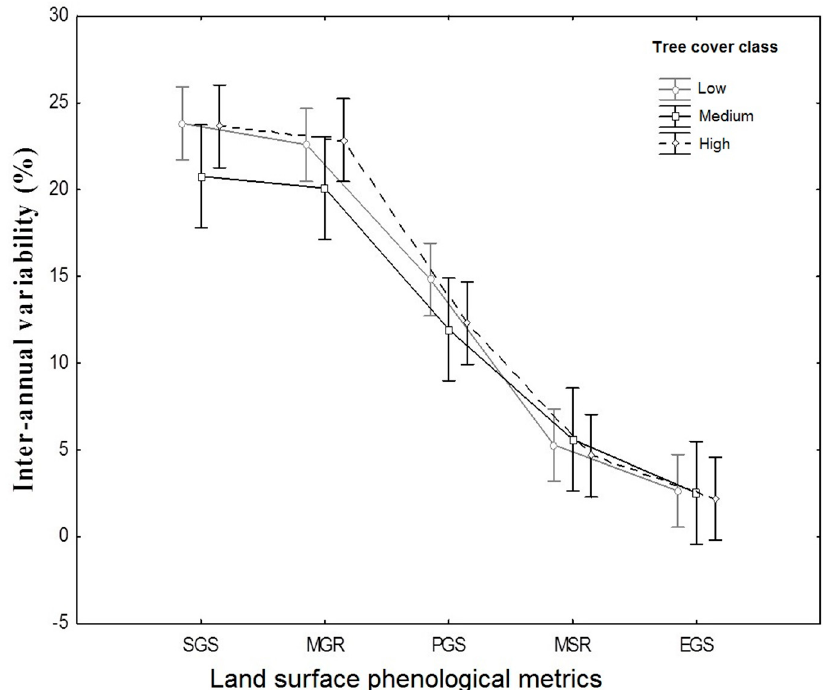
Figure 11. Inter-annual variability in land surface phenological metrics. Vertical bars denote ±95% confidence interval. SGS, MGR, PGS, MSR and EGS denote day of year at Start of growing season, maximum growing rate, peak growth, maximum senescing rate and end of growing season, respectively.